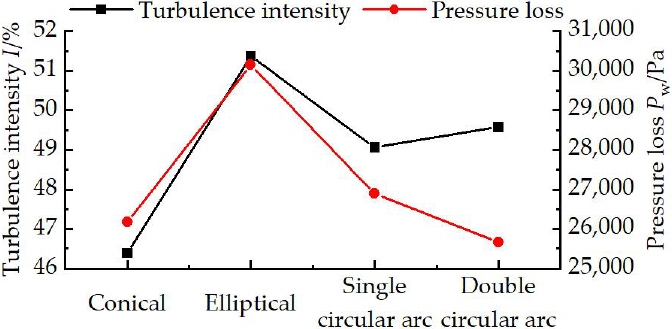
Figure 9. Structure of the nozzle shrinkage section. ( a ) conical, ( b ) elliptical, ( c ) single circular arc, ( d ) double circular arc. Where the nozzle inlet diameter D of 40 mm, the nozzle outlet diameter d of 16 mm and the nozzle shrinkage angle α of 30°.